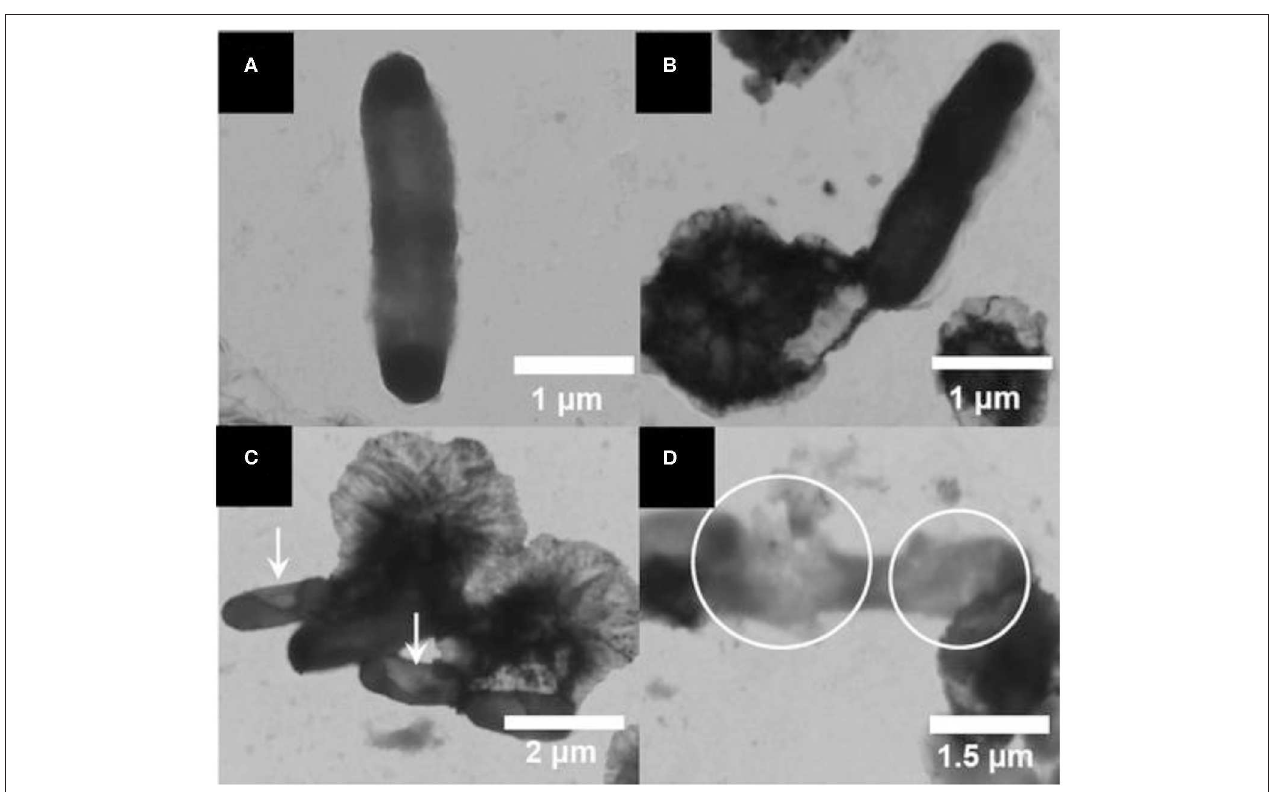
FIGURE 3 | Transmission electron microscopy (TEM) images of E. coli photodegraded by a Ag/TiO 2 /montmorillonite (MT) composite: (A) E. coli , and E. coli illuminated for (B) 0, (C) 2, and (D) 3h under visible light. Reproduced from Wu et al. (2010) with permission from the American Chemical